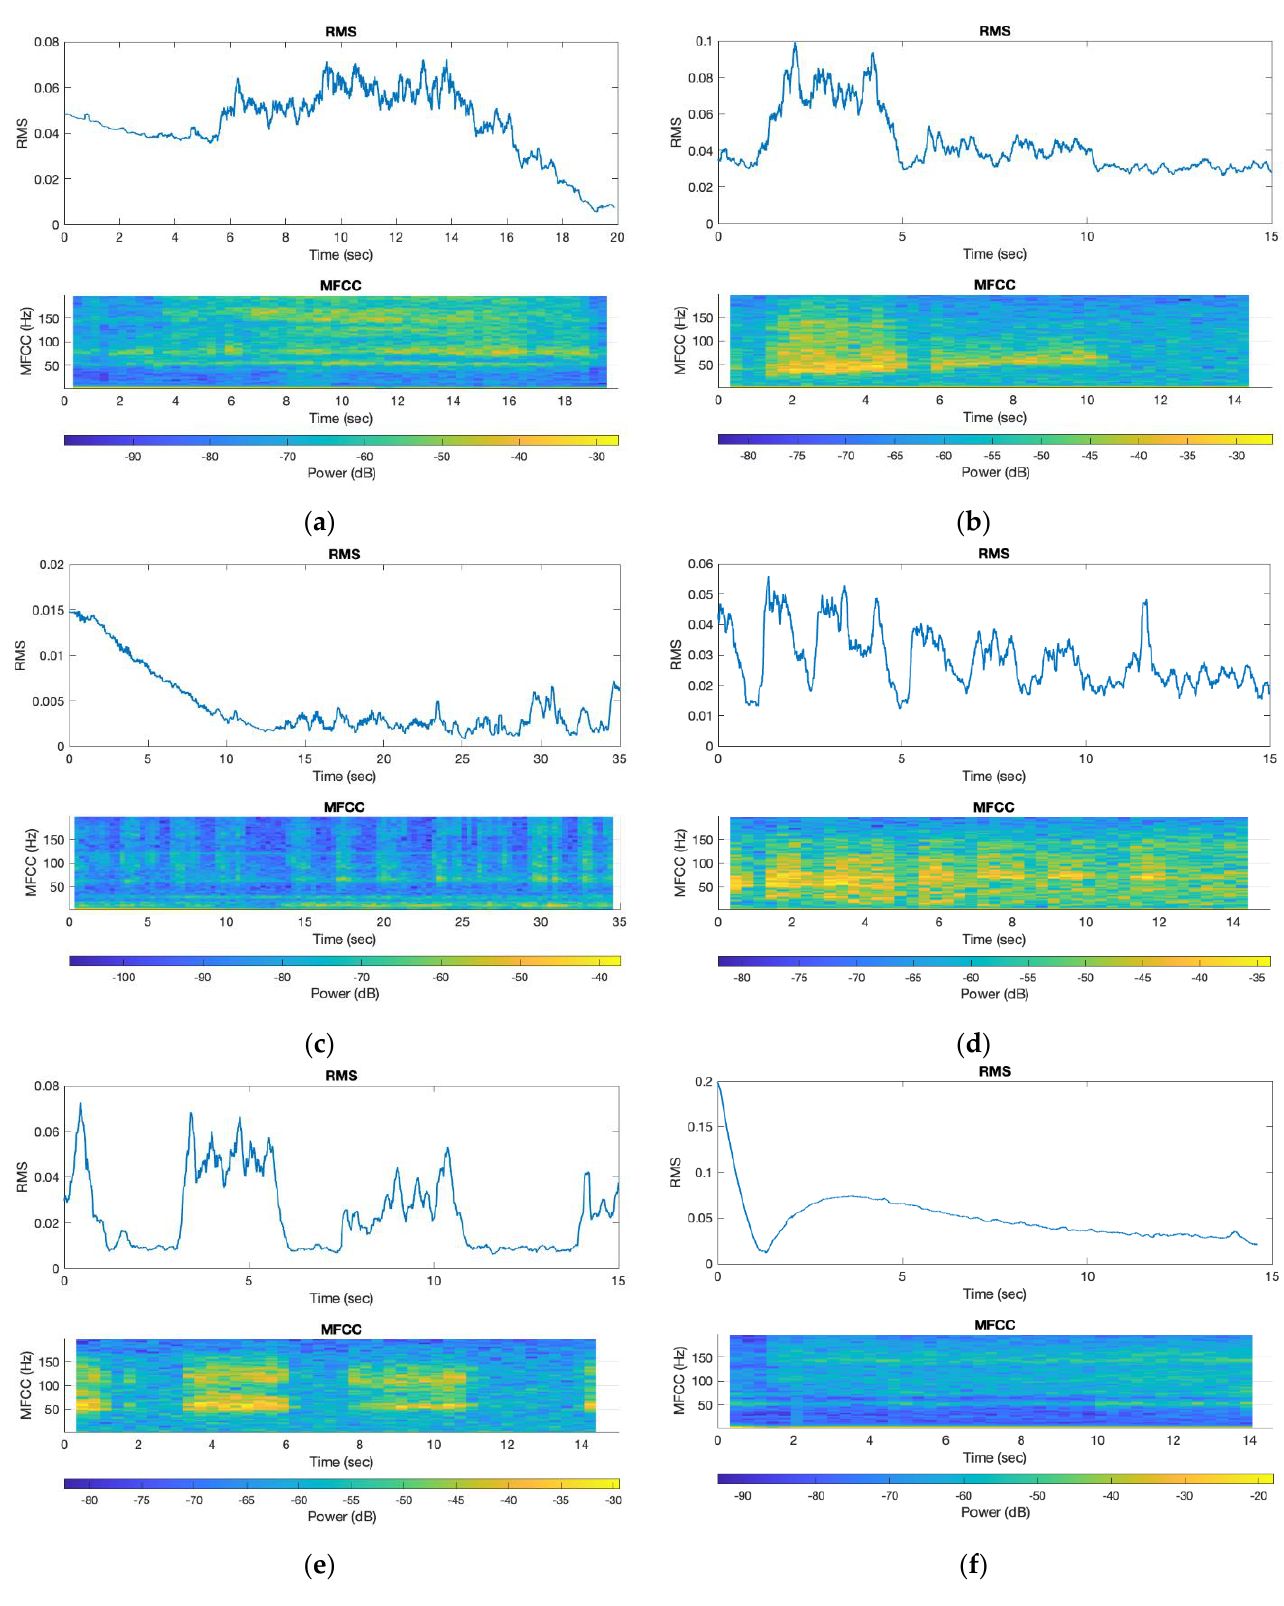
Figure 4. Plotting of RMS signal and MFCC spectrum of cases of six uroflowmetry patterns, including normal case. ( a ) The normal flow; ( b ) The tall and peak flow; ( c ) The decrease flow; ( d ) The saw-tooth flow; ( e ) The intermittent flow; ( f ) The flattened flow.